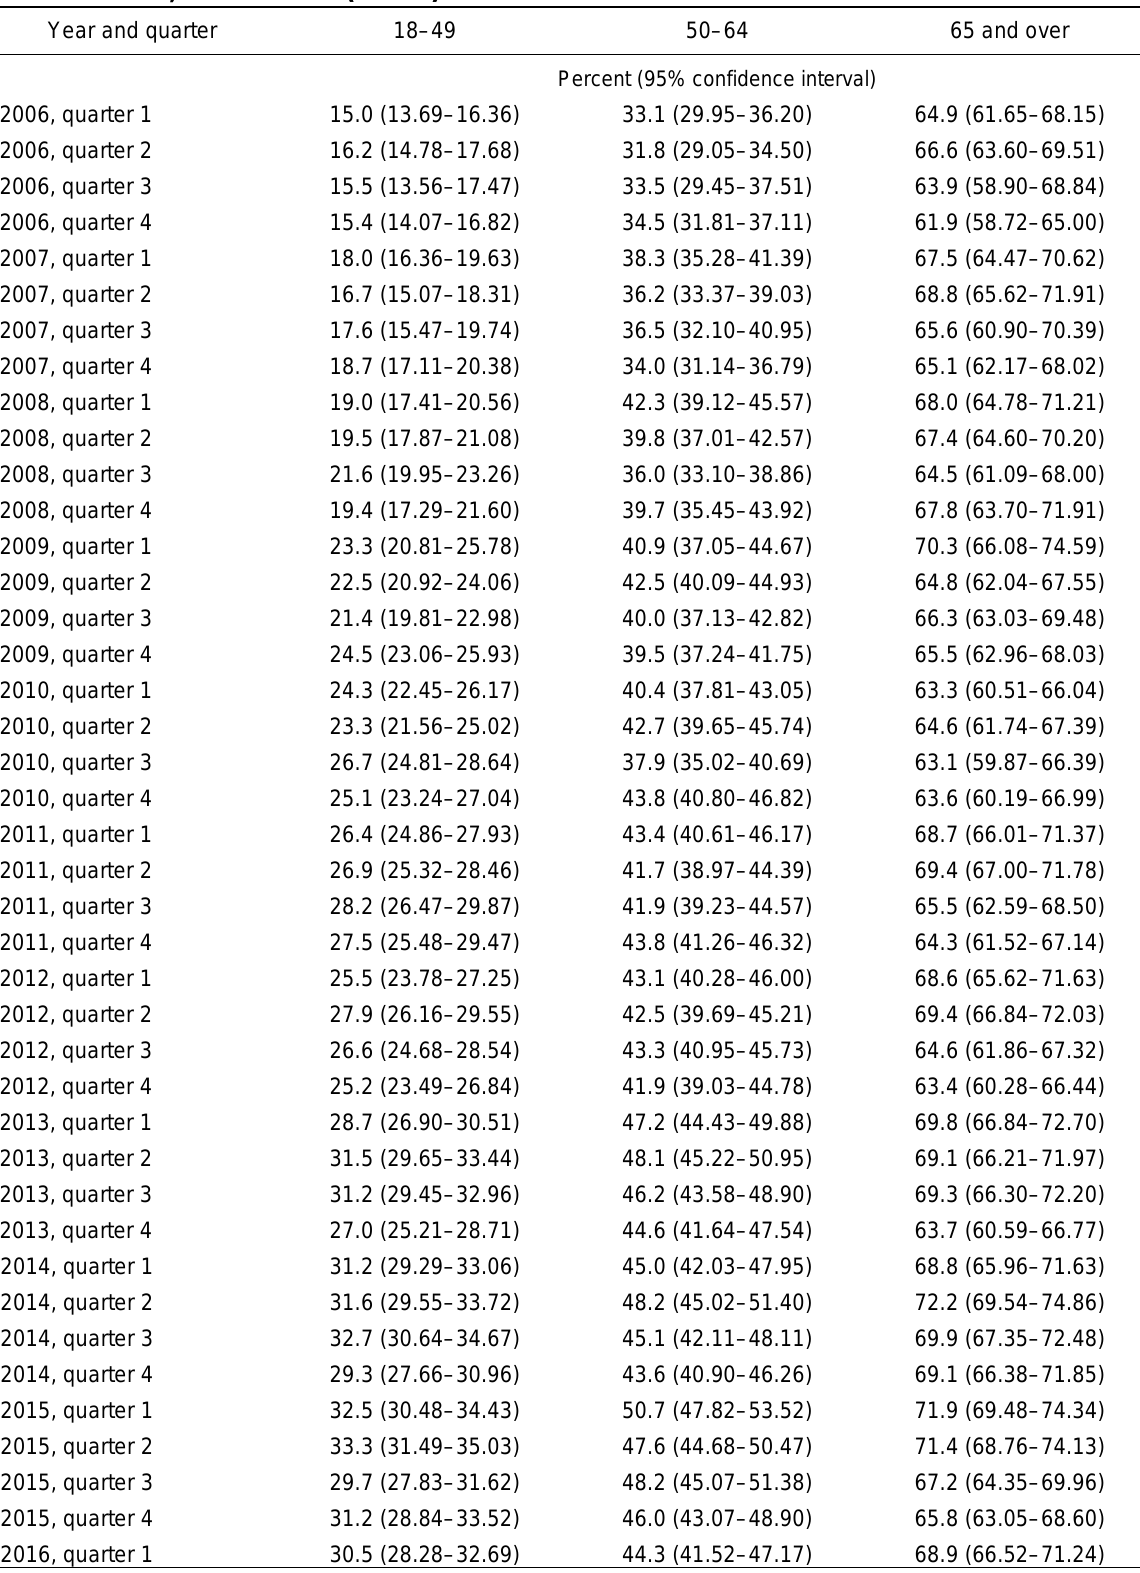
Data table for Figure 4.1. Percentage of adults aged 18 and over who received an influenza vaccination during the past 12 months, by age group and quarter: United States, 1997–2016